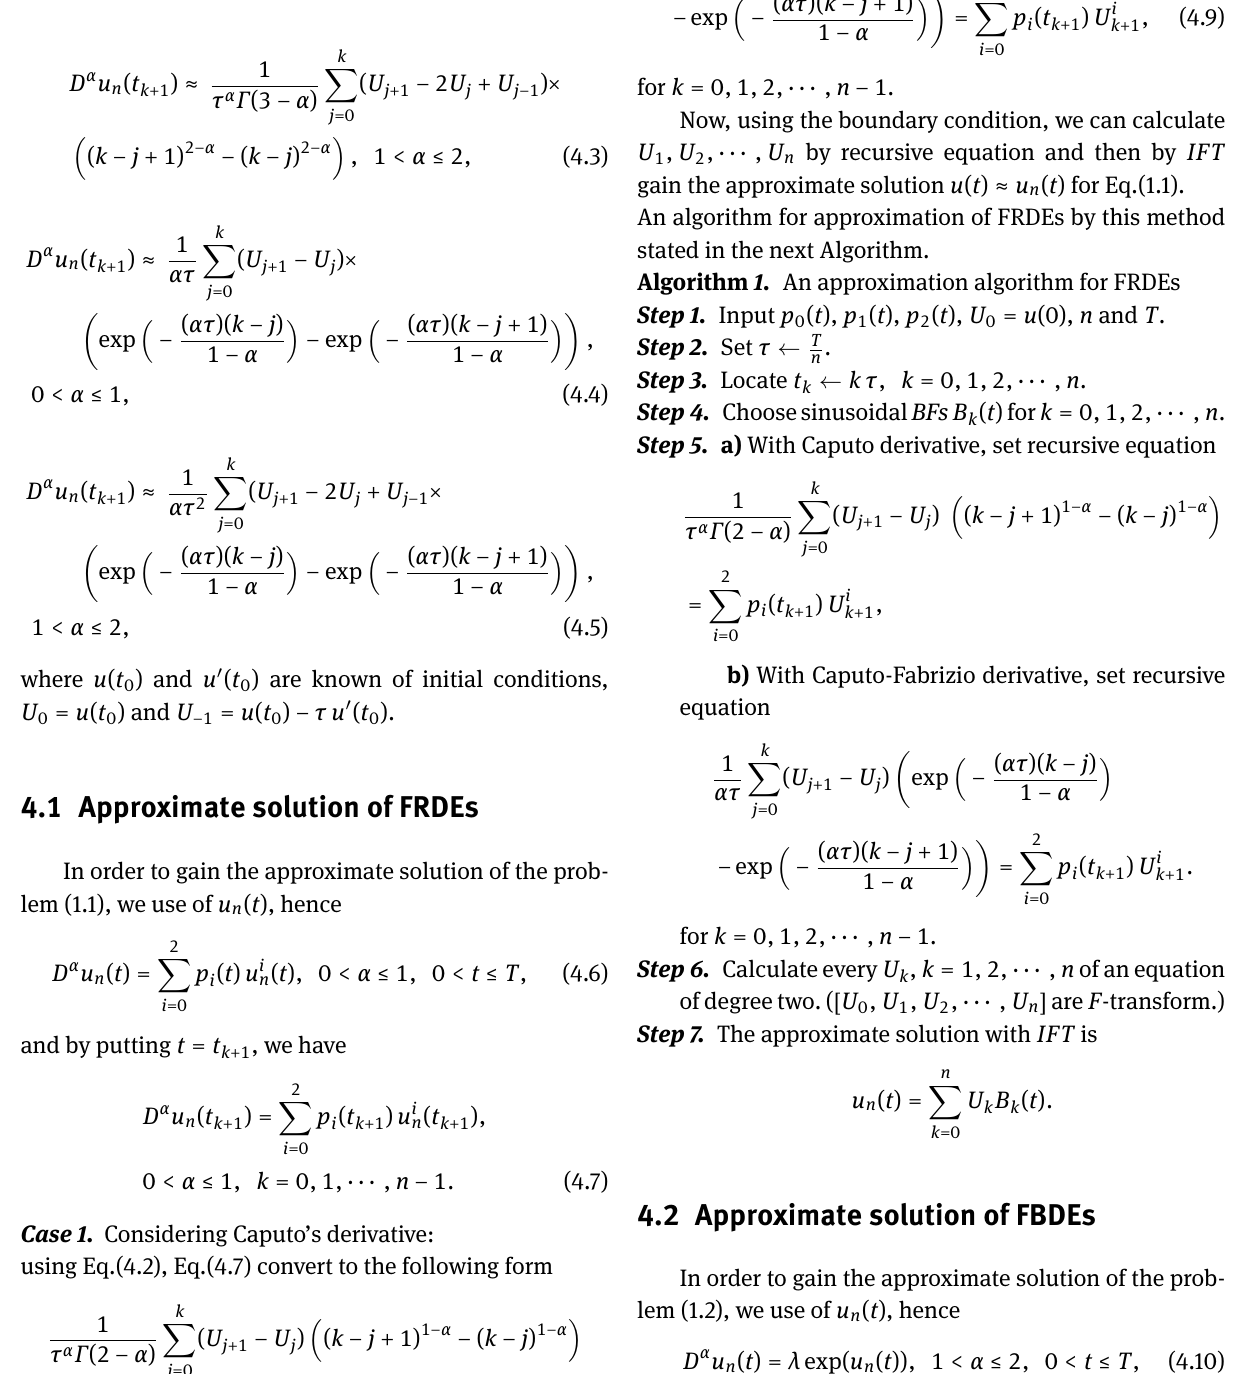
Algorithm 1. An approximation algorithm for